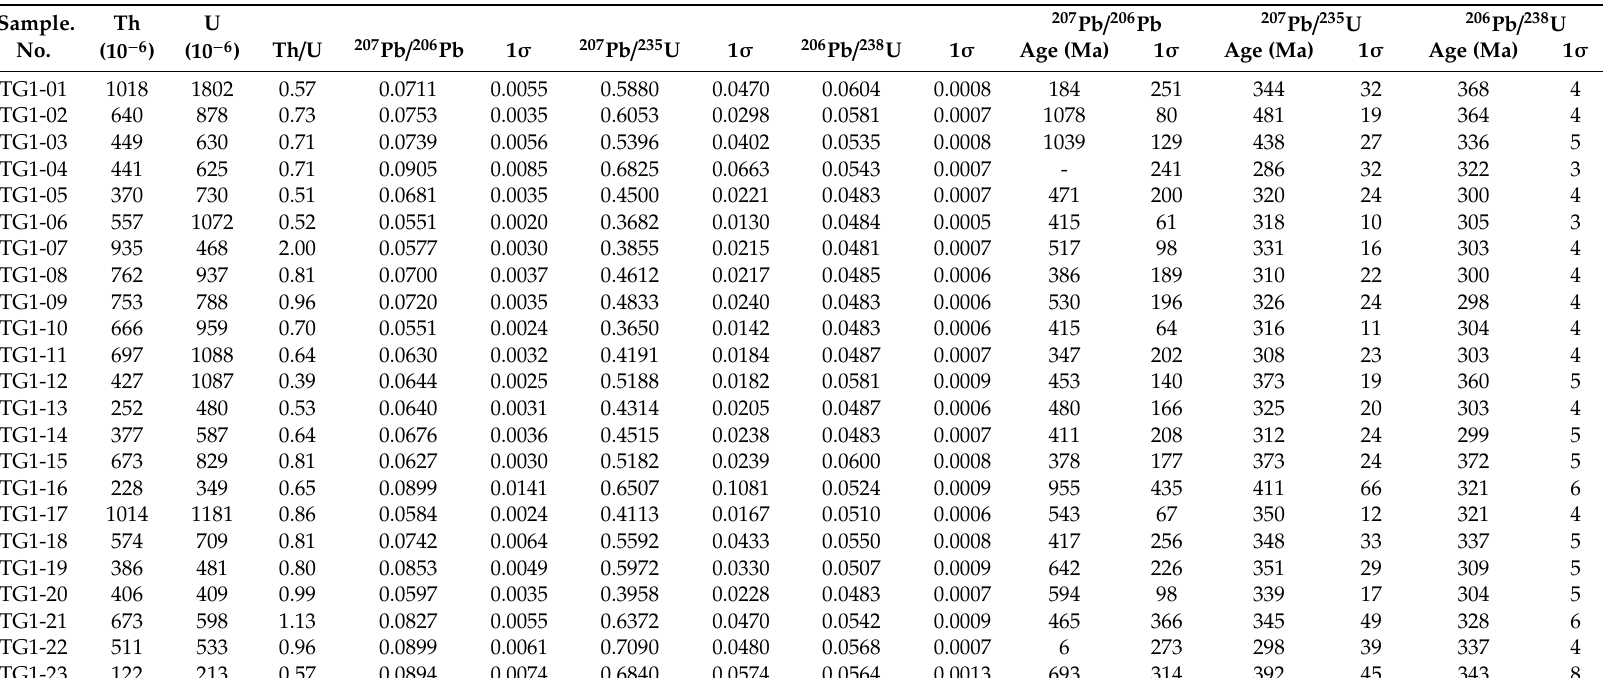
Table 1. LA-ICP-MS U-Pb data on zircons from the